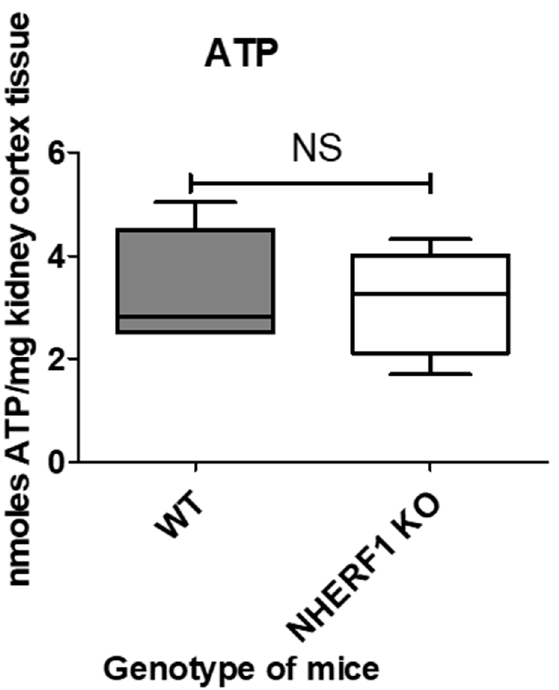
Figure 4. ATP content of WT and NHERF1 KO mouse kidneys.LC-MS was utilized to evaluate the amount of ATP in these tissues as described in the Methods section. Data are means ± SEM (WT n = 5) and (KO n = 5). No significant differences were reported in these kidneys.